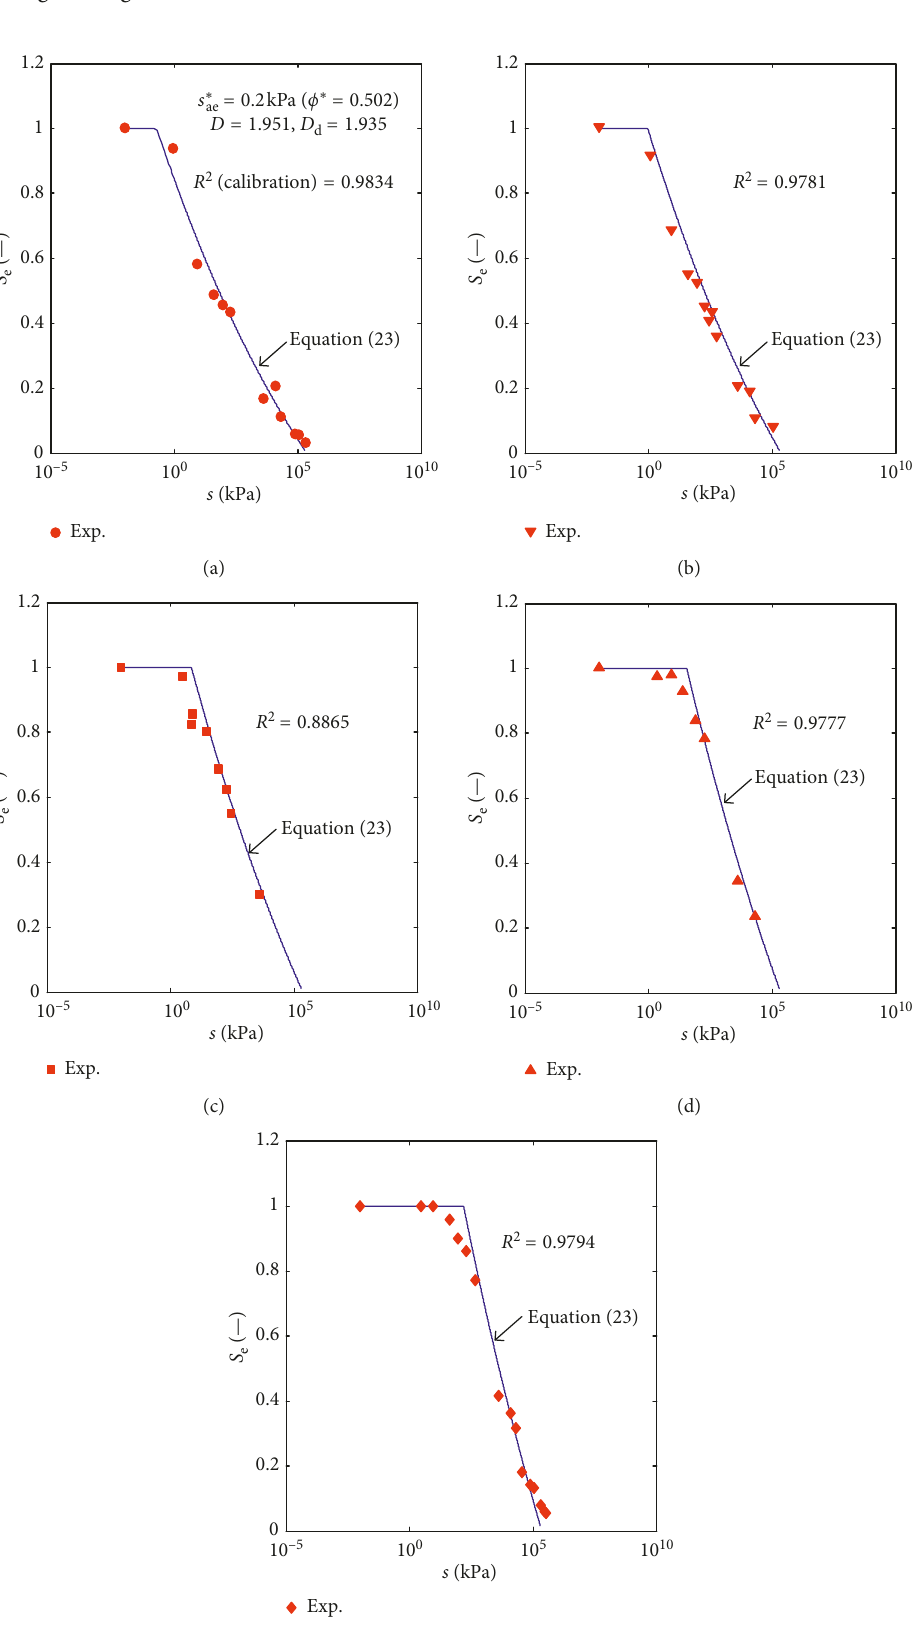
Figure 5: Measured and predicted family of SWRCs for a clayey sand with different initial void ratios (data after Salager et al. [64]): (a) e � 1.01; (b) e � 0.86; (c) e � 0.68; (d) e � 0.55; (e) e �